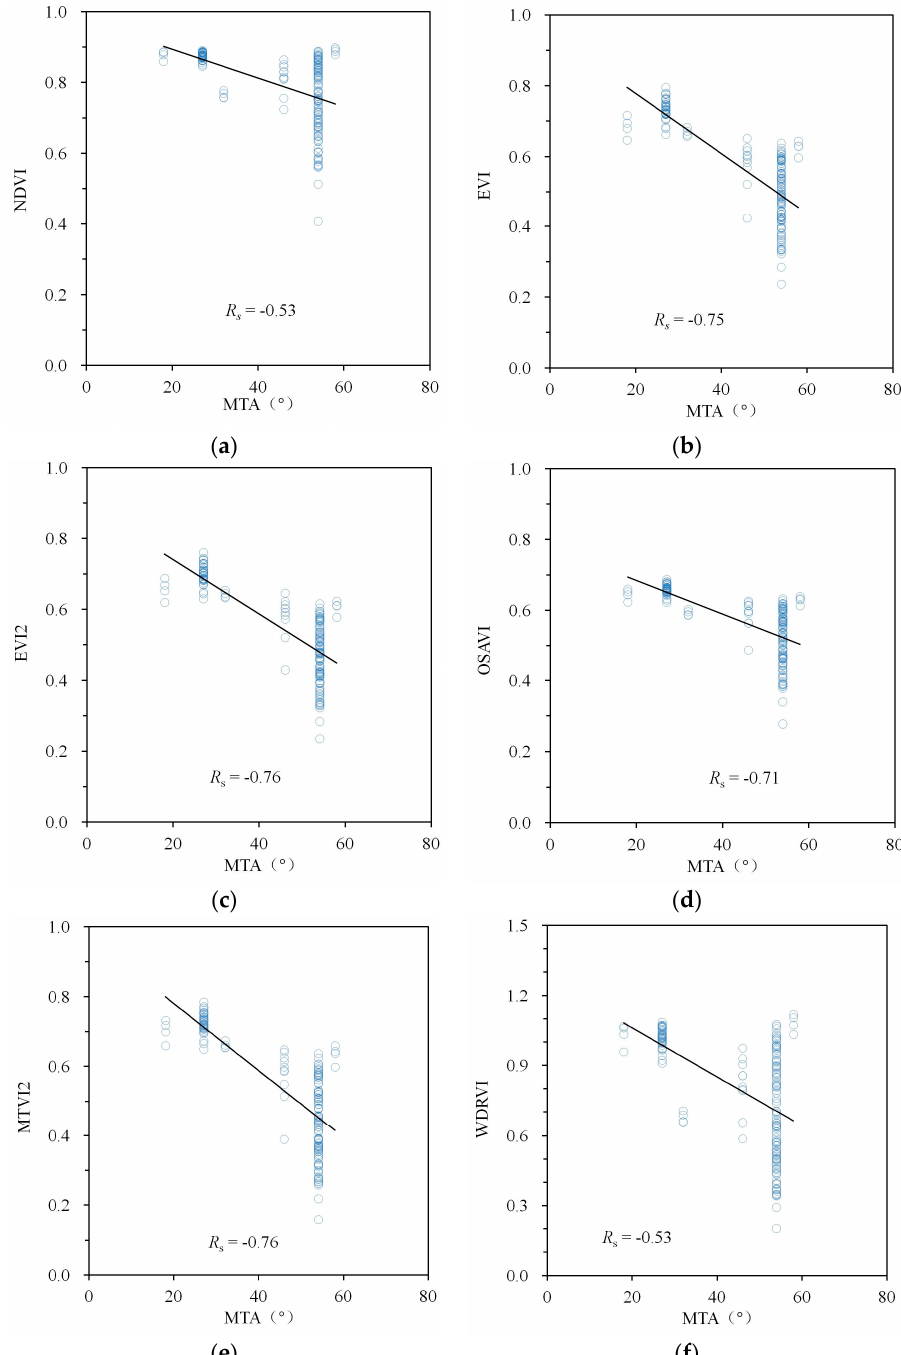
Figure 3. Empirical relationships between MTA and VIs calculated from Spearman’s correlation coefficient Rs: ( a ) NDVI, ( b ) EVI, ( c ) EVI2, ( d ) OSAVI, ( e ) MTVI2, ( f ) WDRVI. A simple trend line calculated from linear regression was added to visualize the trend of the